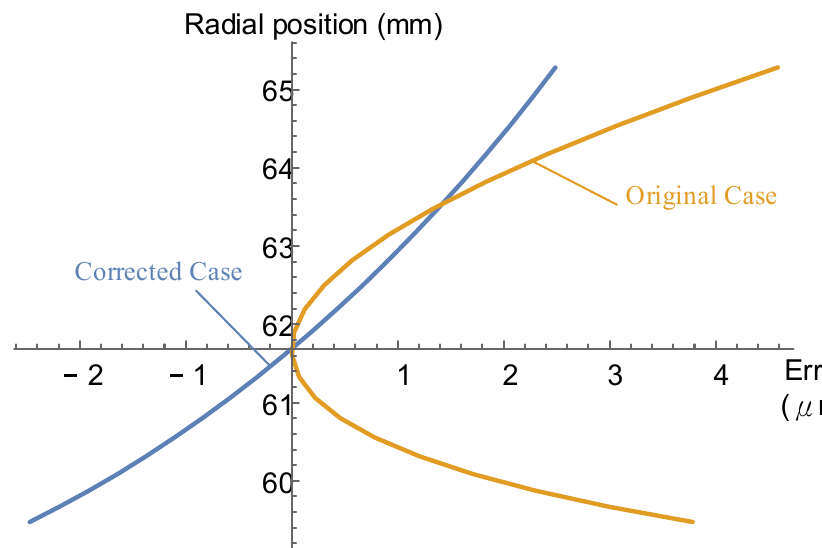
Figure 16. Comparison of the cutter edge profile error for 2.5